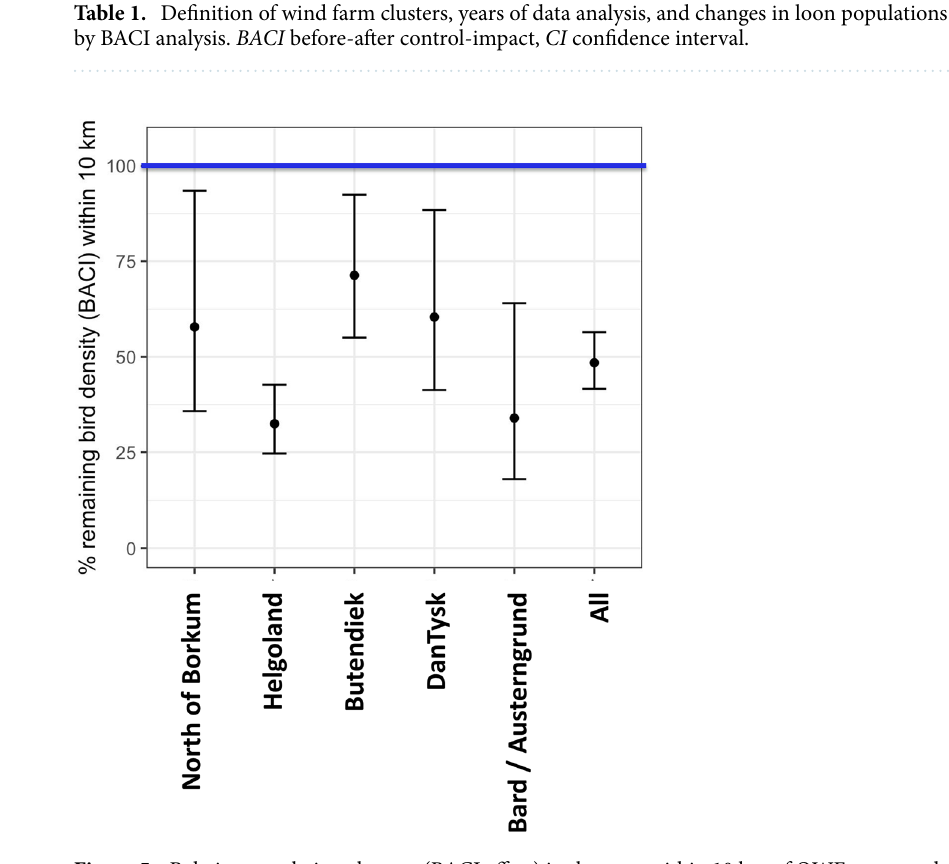
Figure 5. Relative population changes (BACI effect) in the zone within 10 km of OWF compared with the zone outside 10 km of OWF. Data are given for each wind farm cluster as well as for all clusters combined. The blue line represents the abundance of loons in the zone outside 10 km. Mean values indicated by dots; 95% confidence intervals indicated by length of